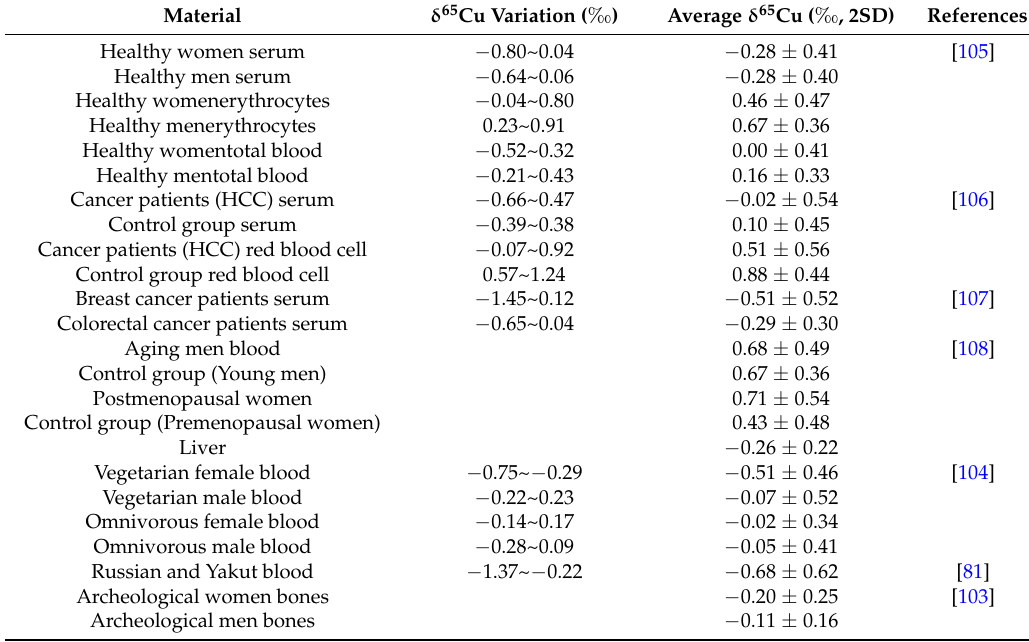
Table 1. Cu isotope composition in blood and bones of Human